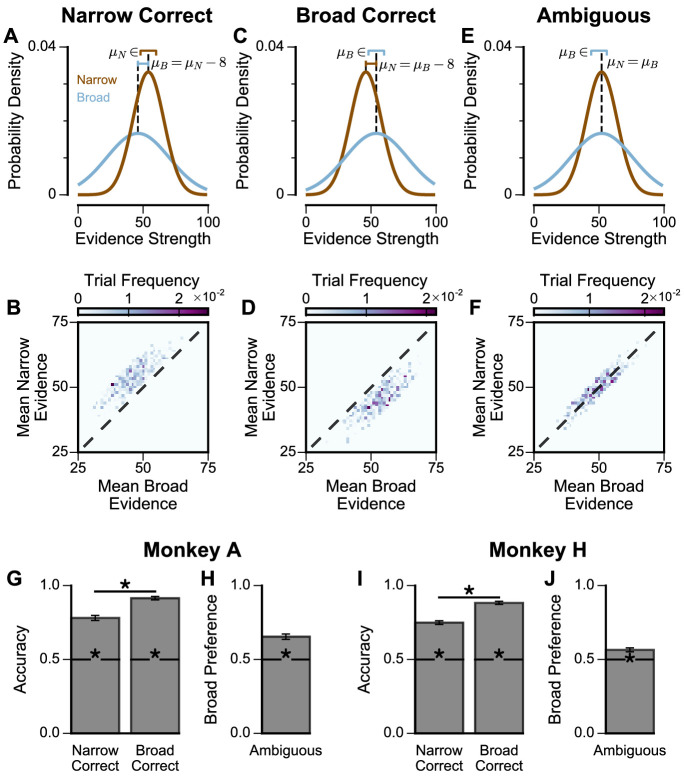
Extra Information on Narrow-Broad Trials, separated by subjects.(A) The generating process of the narrow-correct trials, for each narrow (brown) and broad (blue) stimuli sample. A full stream sequentially presents 8 such stimuli, each for 200ms with a 50ms inter-sample interval in between. In each trial where the narrow choice is correct, the generating mean of the narrow stream, μN, is uniformly sampled from [48,60]. The generating mean of the broad stream, μB, is then set to be μN−8. For all trials, the generating standard deviation of the narrow and broad streams are σN=12, σB=24 respectively. The lines above the distributions denote the ranges of μN and μB. The particular values of μN and μB in this figure are shown for one trial, and chosen arbitrarily for illustration purpose. Given the generating means and standard deviations in a trial, a sequence of 8 stimuli samples are generated from a Gaussian process with certain constraints, for each of the narrow and broad options (See Materials and methods). (B) Sampled distribution of the mean evidence of the narrow and broad streams, across all trials for both monkeys where the narrow option is correct. (C, D) Same as (A, B) but for broad-correct trials. Here, μB is uniformly sampled from [48,60], and μN is set to be μB−8. (E, F) Same as (A, B) but for ambiguous trials. Here, μN and μB are equal and uniformly sampled from [44,56]. (G) The accuracy of Monkey A in the narrow-correct and broad-correct trials. Monkey A was significantly more accurate on ‘Broad-correct’ trials (Chi-squared test, chi = 38.39, p = 5.80x10−10). Errorbars show the standard error. (H) The probability for Monkey A to choose the broad option in ambiguous trials. Monkey A was significantly more likely to choose the broad option (Binomial test, p < 1x10−10). (I) Same as (G) but for Monkey H (Chi-squared test, chi = 59.46, p < 1x10−10). (J) Same as (H) but for Monkey H (Binomial test, p = 3.00x10−6).